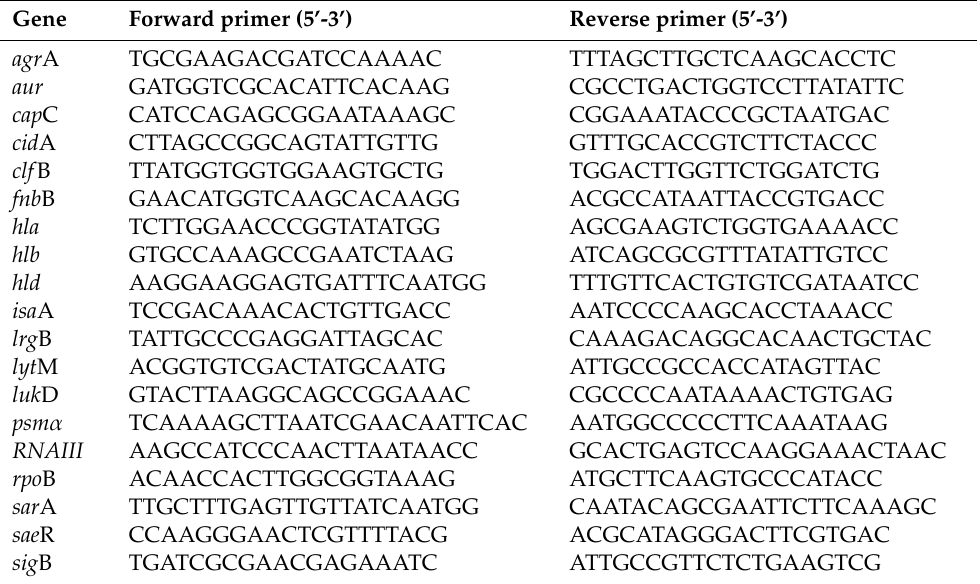
Table 2. Gene target list and oligonucleotide